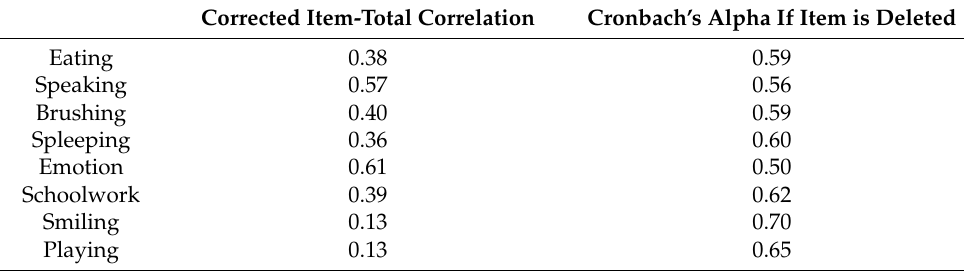
Table 3. Reliability analysis: Corrected item-total